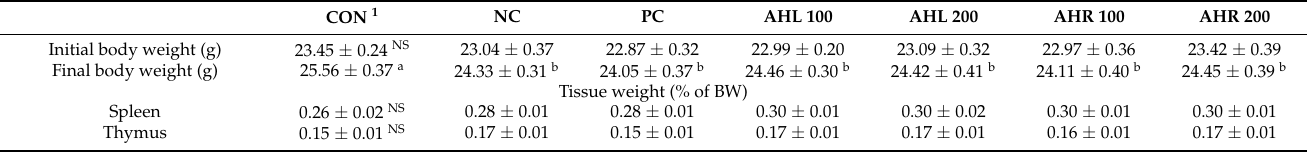
Table 2. Effects of A. hookeri leaves (AHL) and A. hookeri roots (AHR) extracts on the body and organ weights of C57BL/6 mice immunosuppressed by CPA.